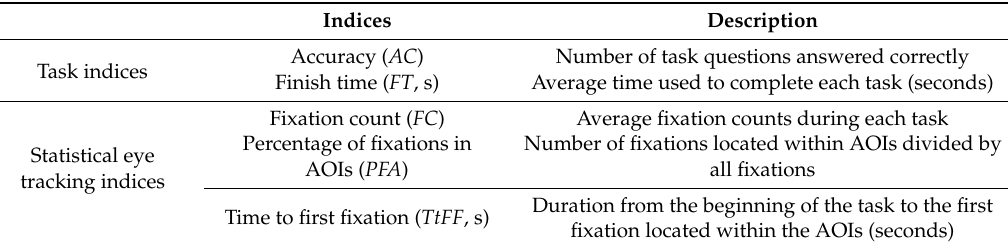
Table 2. Analysis indices and